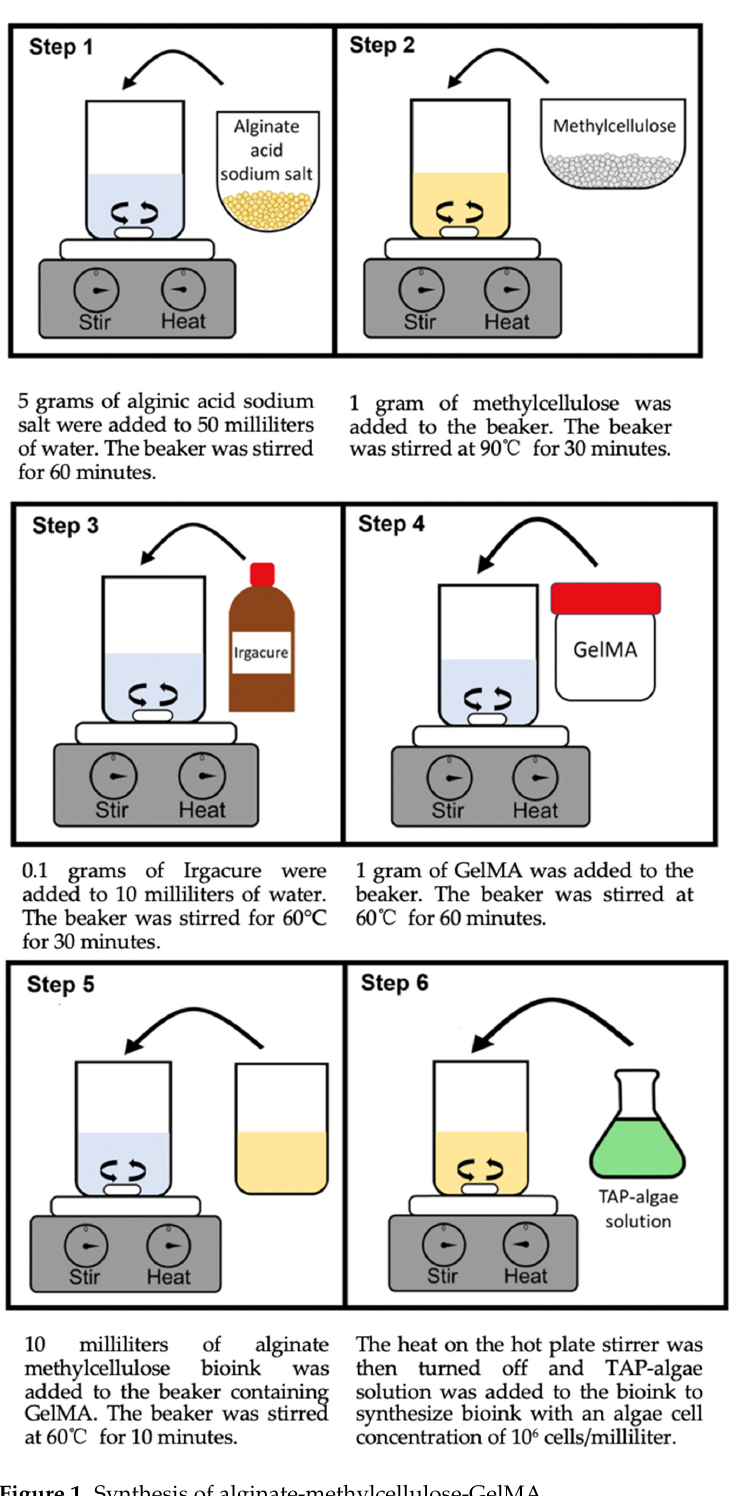
Figure 1. Synthesis of